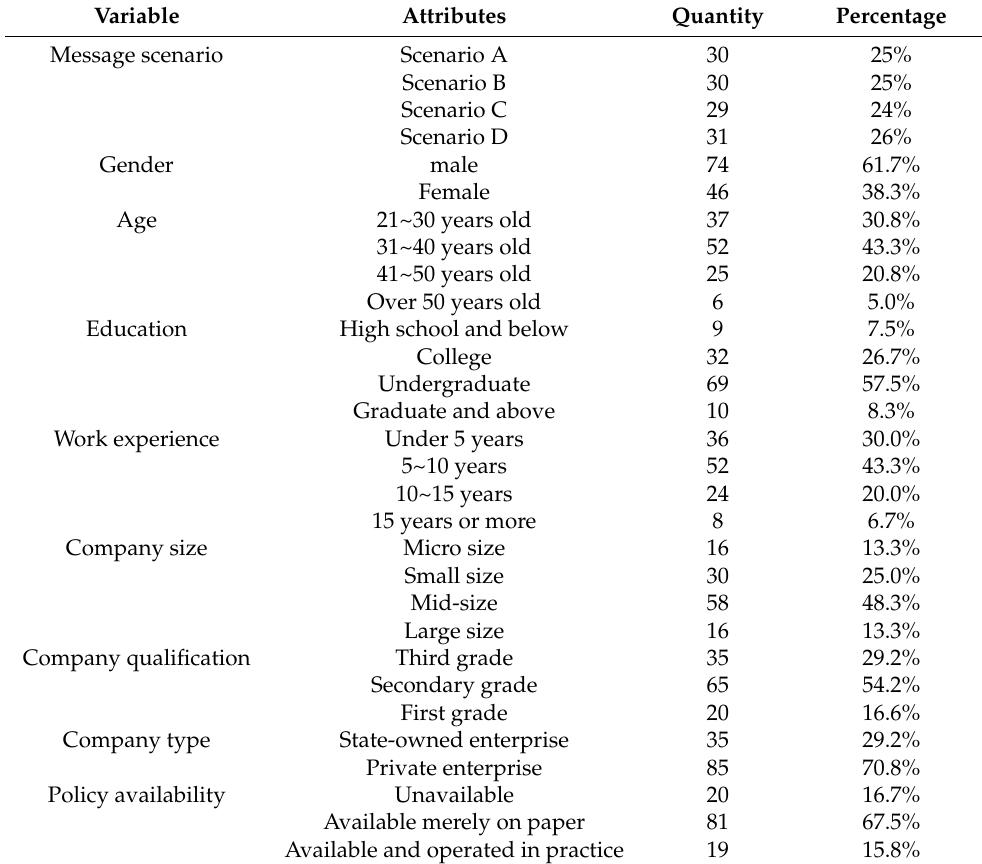
Table 3. The background information of the